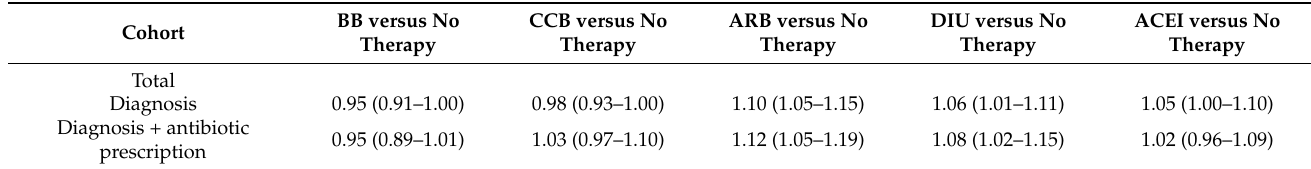
Table 3. Association between antihypertensive therapy class (as compared to patients without therapy) and the incidence of pneumonia and acute bronchitis in patients followed in general practices in Germany (Cox regression